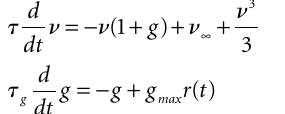
FIgure 12 | The tau-cell neuron circuit.